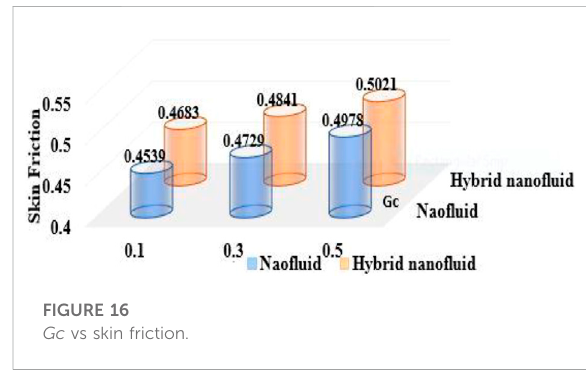
FIGURE 18 ϕ ϕ 1 , 2 vs Nusselt number enhancement in